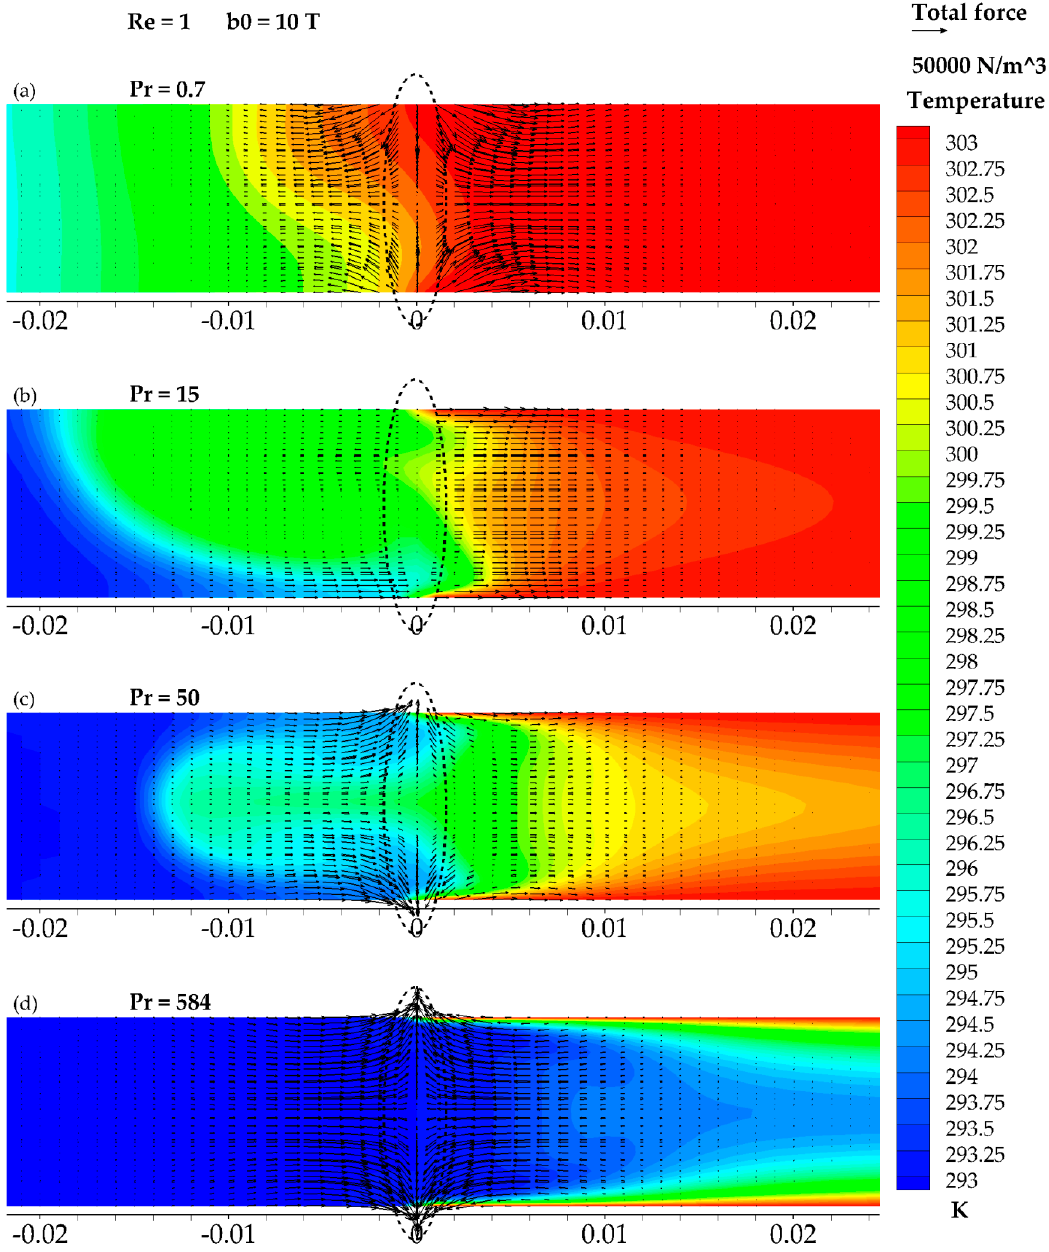
Figure 11. Temperature and total force distribution in the axial cross-section at Re = 1 and b 0 = 10 T: ( a ) Pr = 0.7, ( b ) Pr = 15, ( c ) Pr = 50, ( d ) Pr = 584.